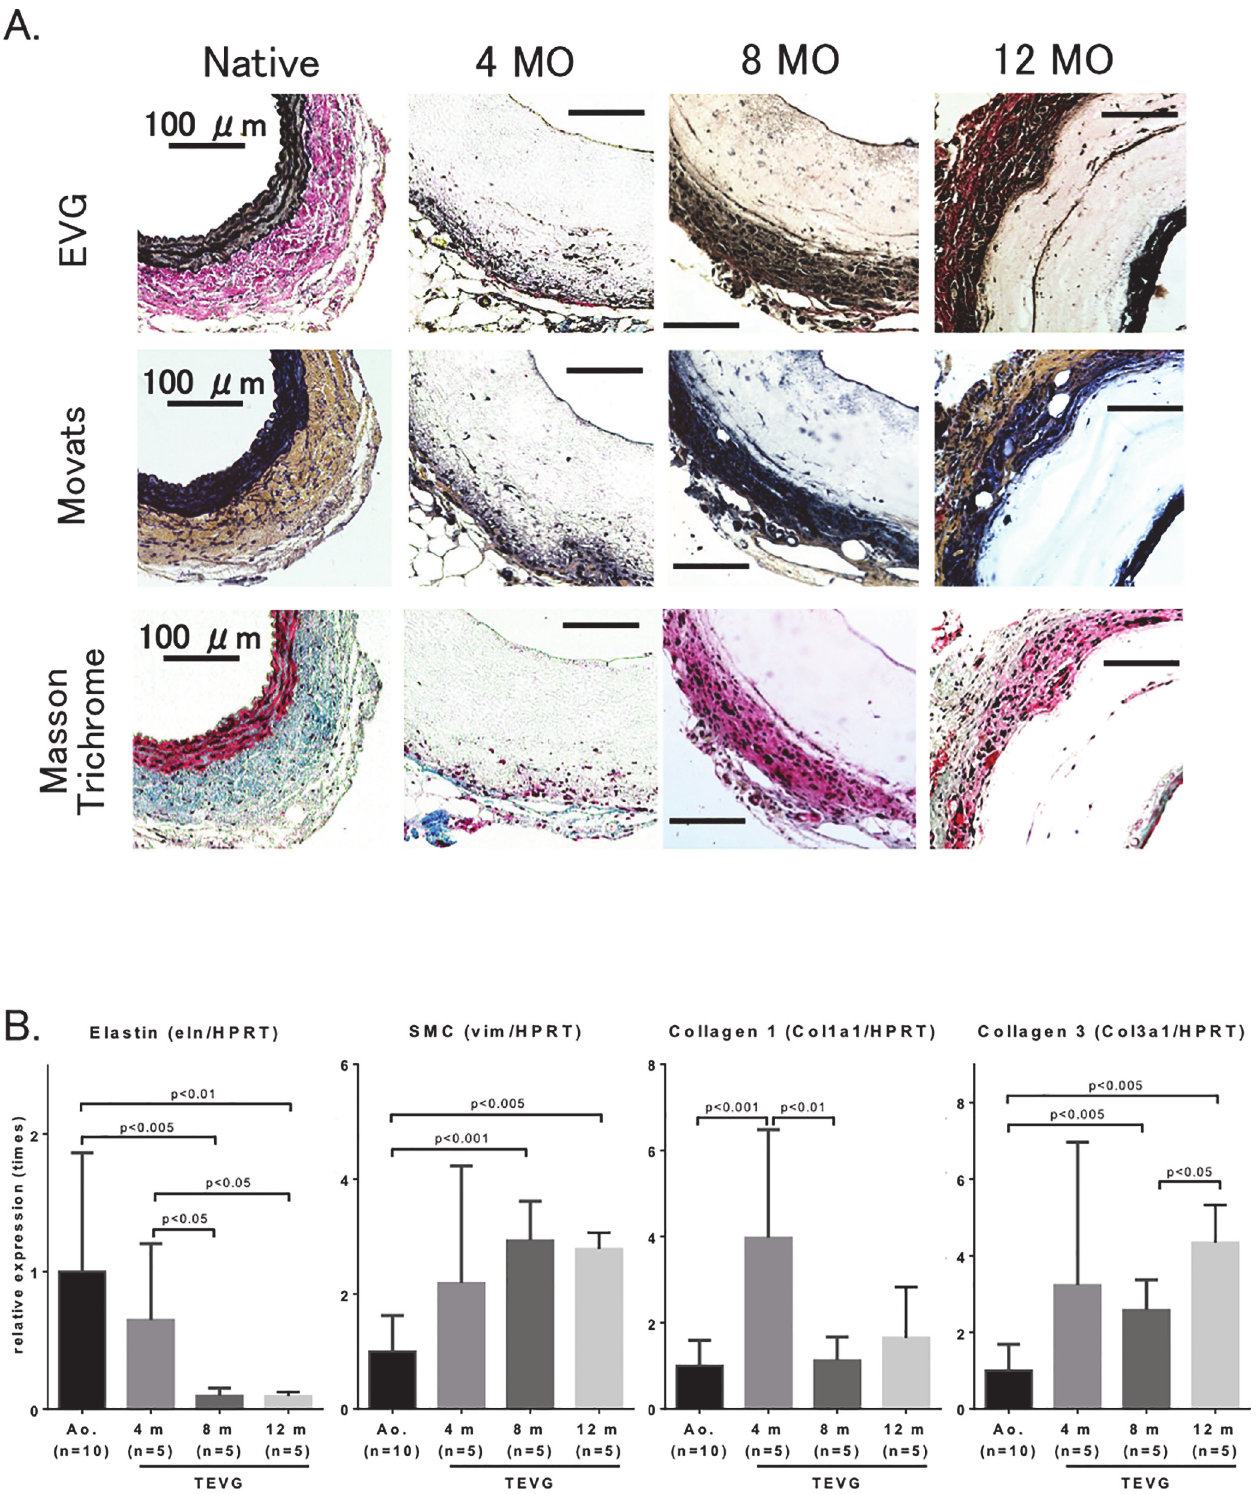
Fig 5. Extracellular matrix deposition was evident in TEVG over the course of the 12-month experiment. A. Histologic analysis of graft tissue testing for elastin (EVG: Elastica van Giesen), collagen, elastic and cellular architecture (Movat ’ s and Masson trichrome) (n = 5 in each group). There is minimal elastin within the graft as compared to that that seen in native aorta. There is presence of endothelial and adventitial cells of the grafts with neo-collagen